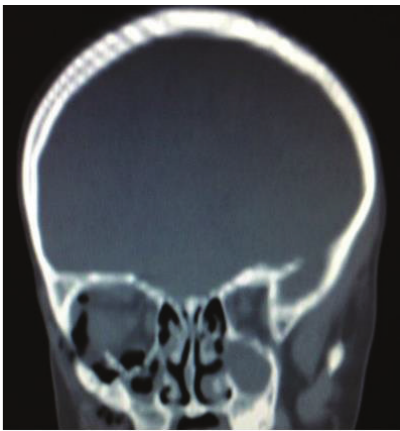
Figure 1: Coronal slice showing impingement of floor into globe.